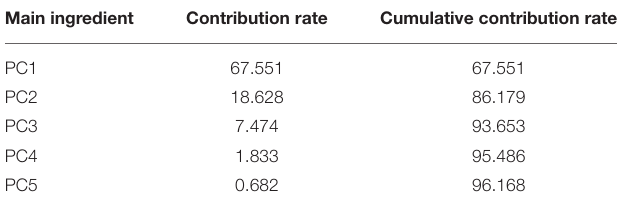
TABLE 3 | Contribution rate and cumulative contribution rate of the first five principal components (acidic condition).